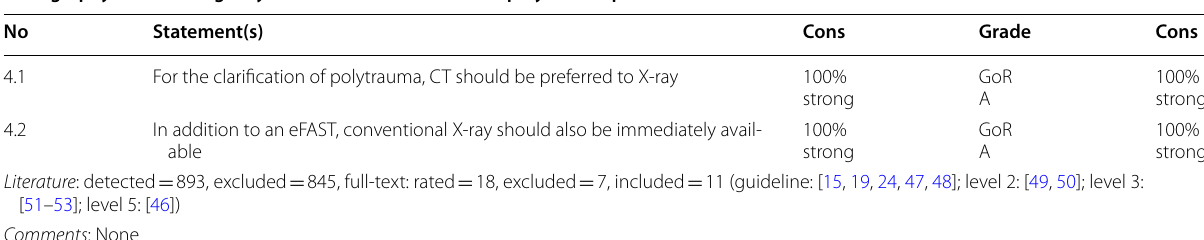
Table 7 Section 4: Conventional